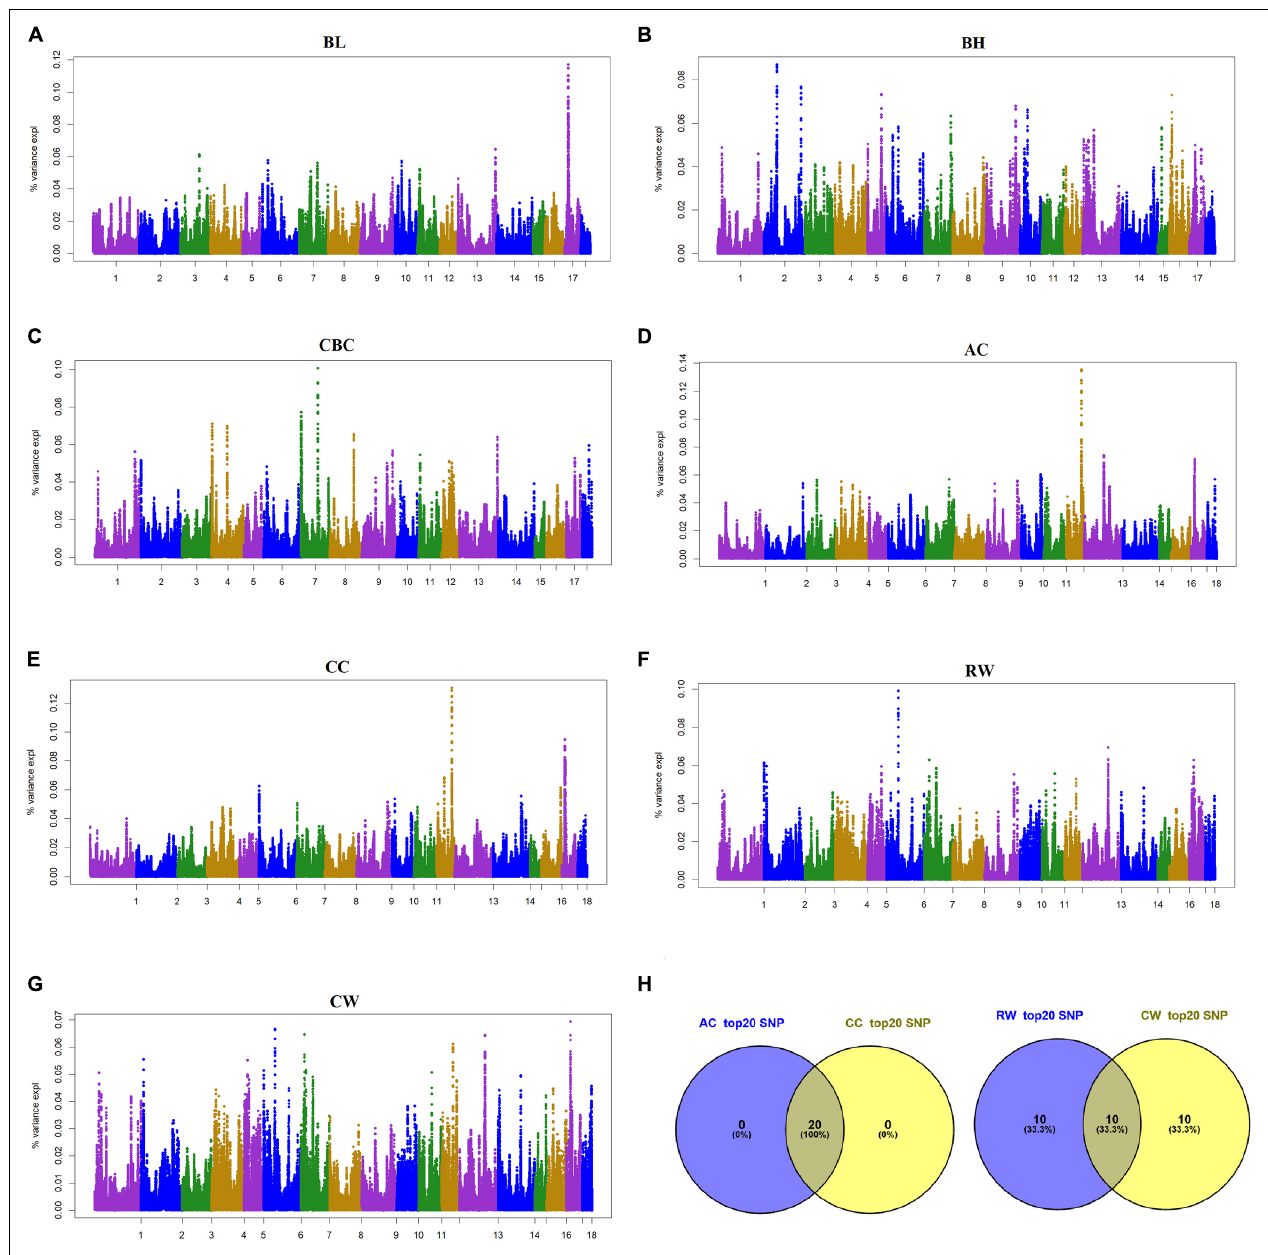
FIGURE 3 | Manhattan plot of the genome-wide association study on seven body size traits and Venn plot of SNPs according to the contribution of SNP to genetic variance by using ssGWAS. BL, Body length; BH, Body height; CBC, Cannon bone circumference; AC, Abdominal circumference; CC, Chest circumference; RW, Rump width; CW, Chest width. BL, BH, and CBC were single-trait models, AC, CC, RW, and CW were two-trait models. AC and CC are a pair of traits, RW and CW are a pair of traits. In the Manhattan plots (A–G) , the proportion of genetic variance of the quantified SNPs were plotted against their genomic positions. The x -axis represents the chromosomes and the y-axis represents the percentage of SNP explaining the genetic variance. Different colors indicate different chromosomes. Venn plot (H) of SNPs for the two pairs of body size traits, AC and CC, RW, and CW are a pair of traits,